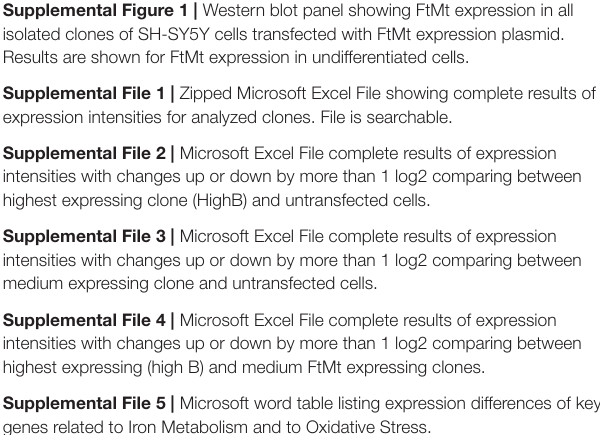
FIGURE 7 | ANOVA with Tukey’s post-hoc test of significance. Results indicate level of significance. * p < 0.05; ** p < 0.01. (E) Real time PCR measurement of expression of growth differentiation factor-15 (GDF-15) in different clones. Results are combined of three independent experiments. Data analyzed by one-way ANOVA with Tukey post-hoc test of significance. Results indicate level of significance. ** p < 0.01. (F) Real time PCR measurement of expression of calcitonin gene related peptide alpha (CALCA) in different clones. Results are combined of three independent experiments. Data analyzed by one-way ANOVA with Tukey’s post-hoc test of significance. Results indicate level of significance. ** p < 0.01. (G) Real time PCR measurement of expression of secretogranin-2/chromogranin C (SCG-2) in different clones. Results are combined of three independent experiments. Data analyzed by one-way ANOVA with Tukey’s post-hoc test of significance. Results indicate level of significance. * p <